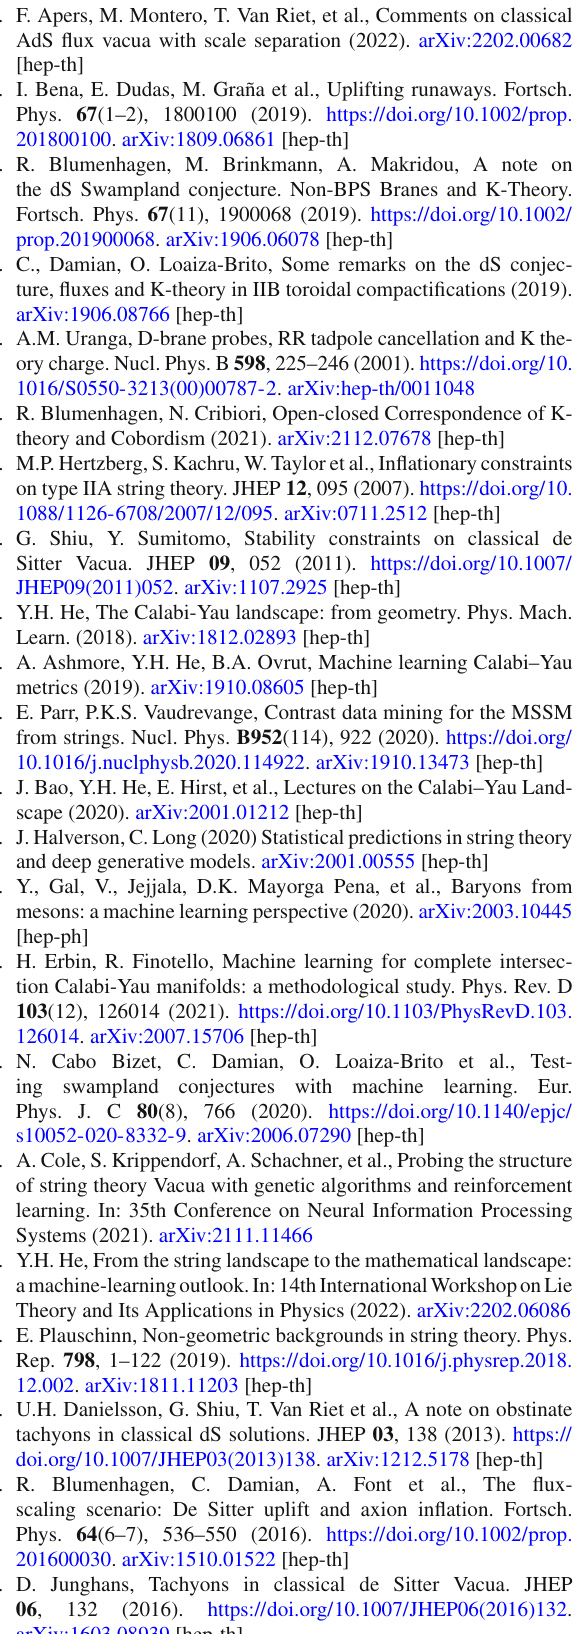
(cid:2) D 5 5 fluxes but not